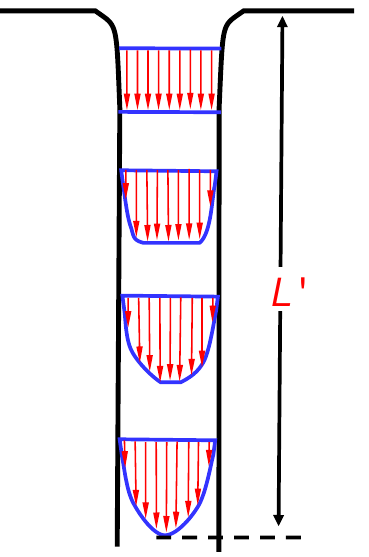
Figure 3. Schematic representation of velocity profile in a fully developed laminar flow.